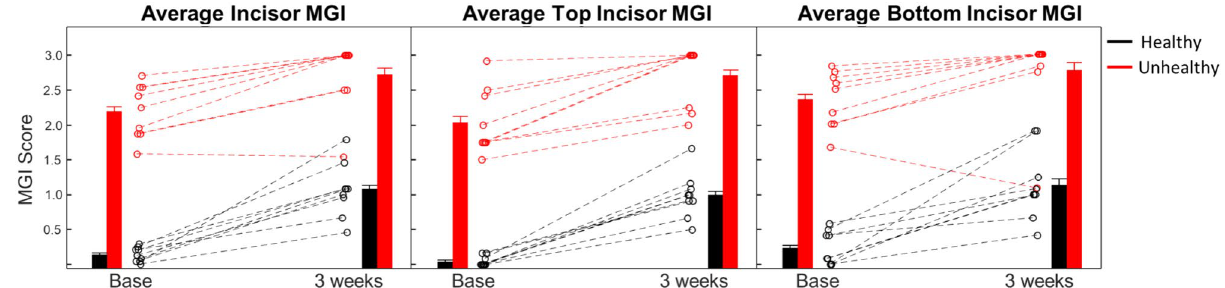
Figure 2. MGI scores of the incisors from healthy and unhealthy panelists at baseline and 3 weeks. (Left) The average MGI of the incisors. (Center) The average MGI of the top incisors. (Right) The average MGI of the bottom incisors. Data from each of the individual panelists is indicated with a dashed line to show how the individual score changed. Bar graphs show the average trend of the healthy (black) and unhealthy (red) groups. Error bars on the bar graph are the Standard Error of the Mean for each group.